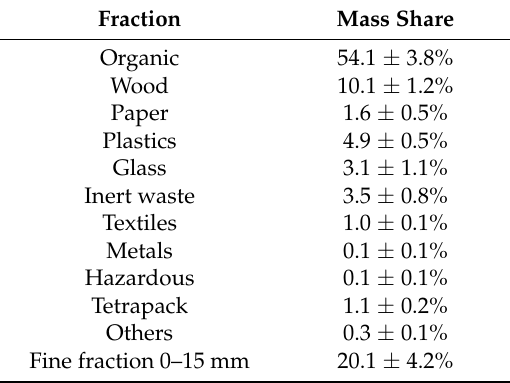
Table 2. The composition of the OFMSW.